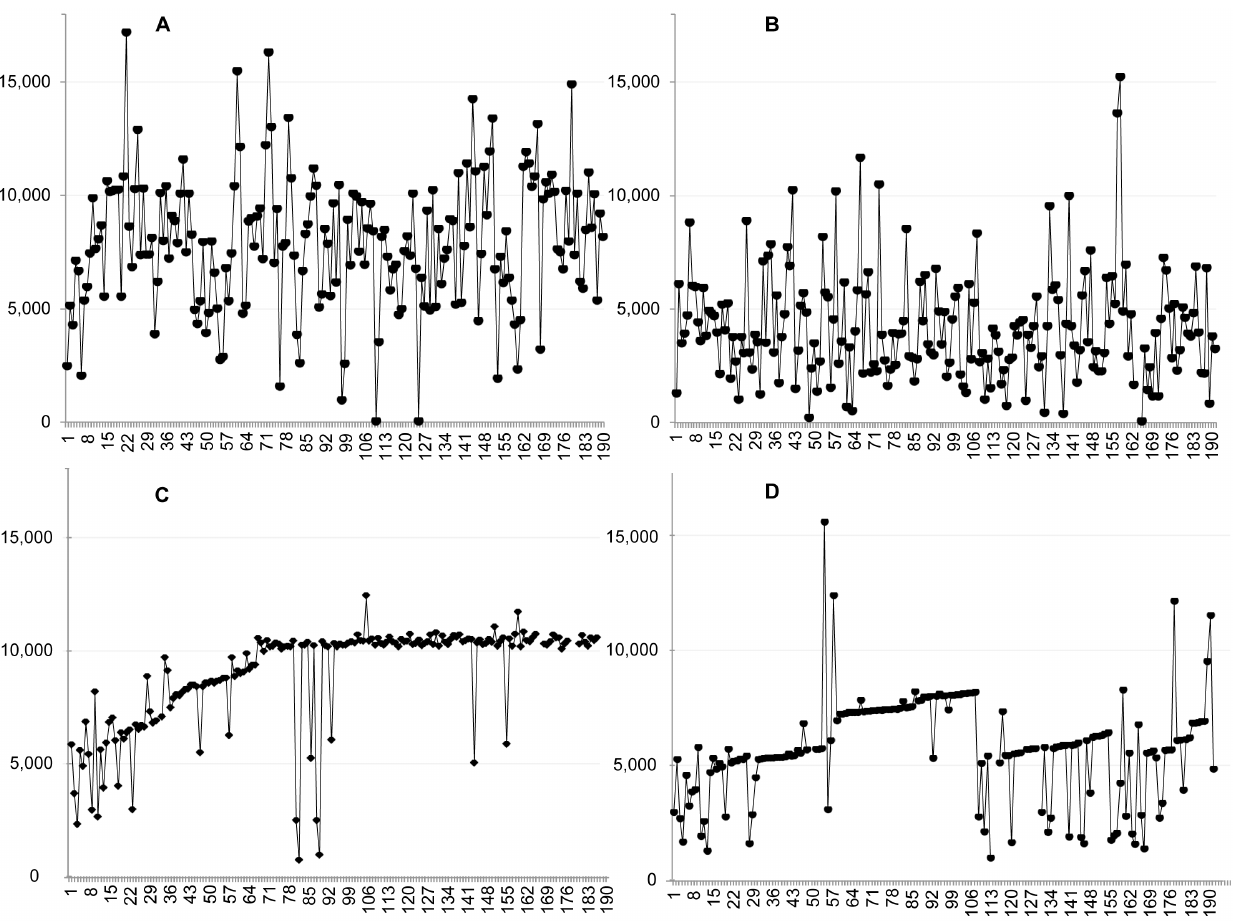
Figure 4. Plots of observed intra-subject variation in steps/day over 6 months for four participants by group. Panels A–D show differences observed in level, trend, and variability on steps/day over 6 months for 4 participants. Panels A and B show participants in the Static Intervention and panels C and D show participants in the Adaptive Intervention. These intra-subject observations are not visible in aggregated group data, but are important discriminations in adaptive interventions.